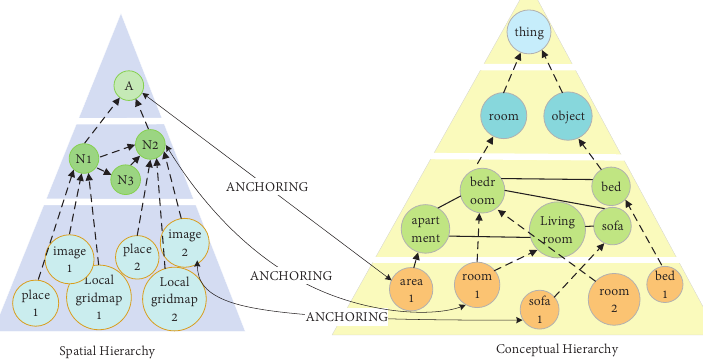
Figure 21. The semantic map concept mentioned in Galindo’s article.